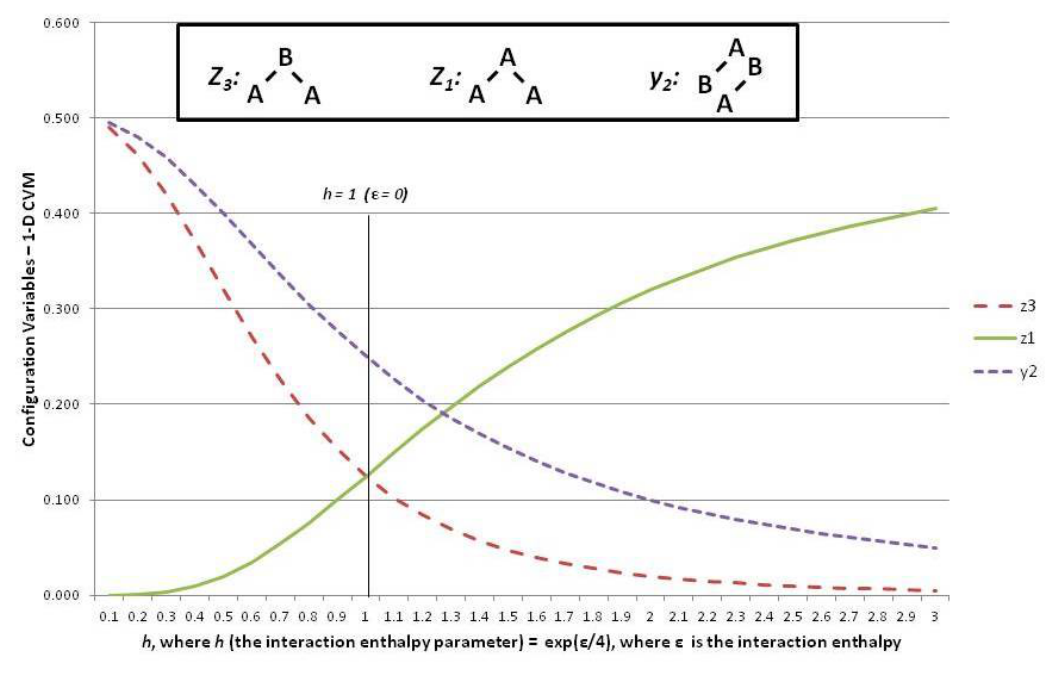
Figure 6. Results for three of the configuration variables, z 3 , z 1 , and y 2 , used in the cluster variation method. Values for h are plotted along the